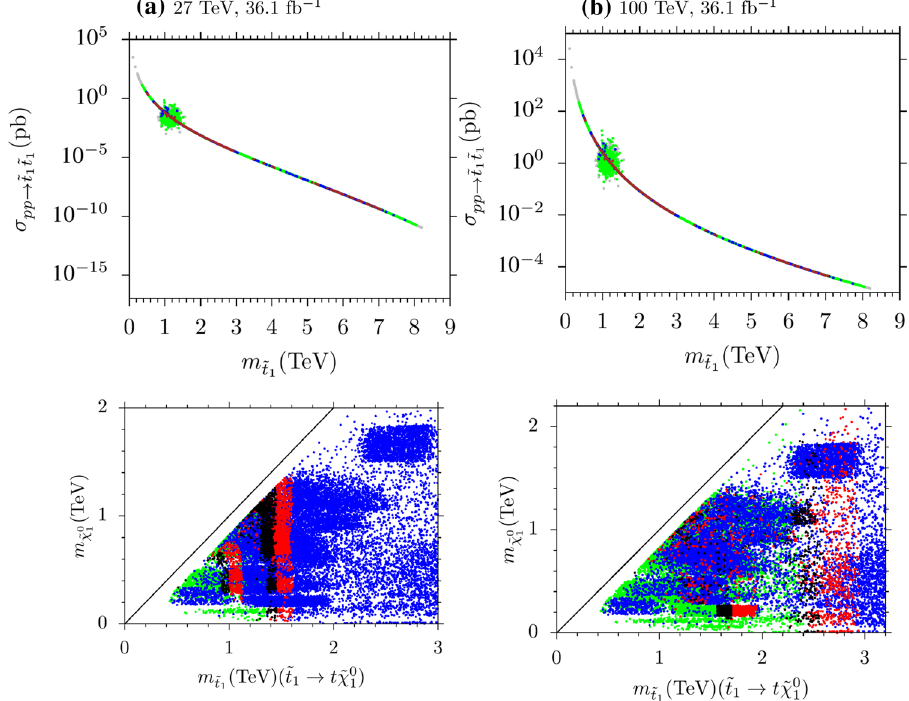
− m ˜ and m ˜ χ 0 t 1 planes at 27 TeV 1 1